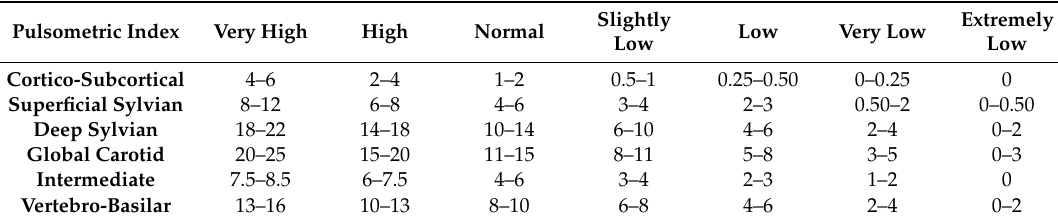
Table 2. Estimates normal values of mean pulsometric indexes (MPI) in the different region considered [26].